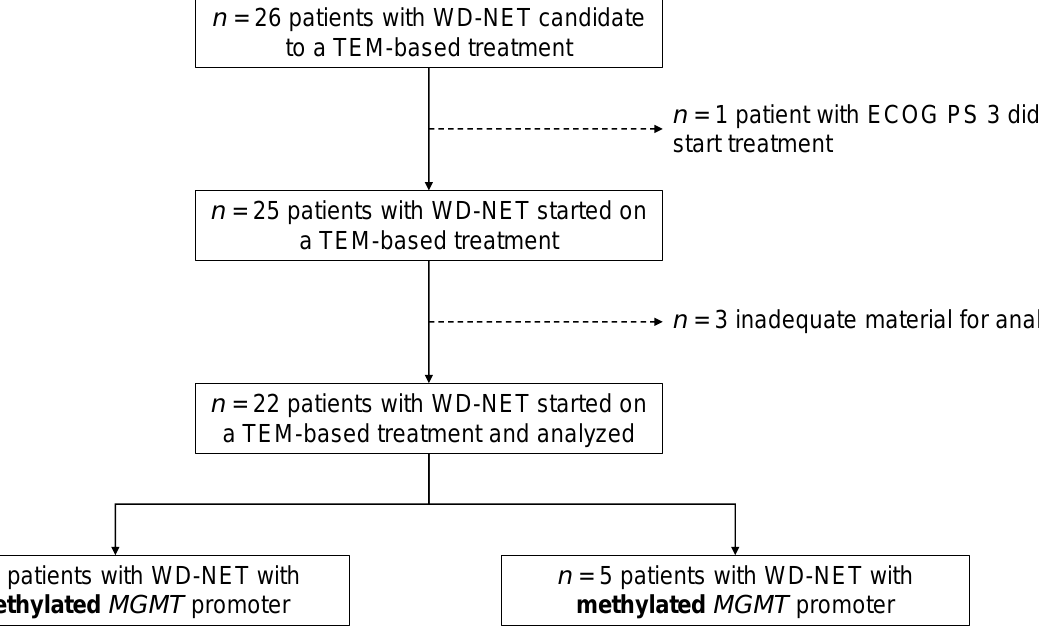
Figure 1. Study flow-chart. WD-NET—well-differentiated neuroendocrine tumors; ECOG PS— Eastern Cooperative Oncology Group performance status; TEM—temozolomide; MGMT—O6- methylguanine-DNA